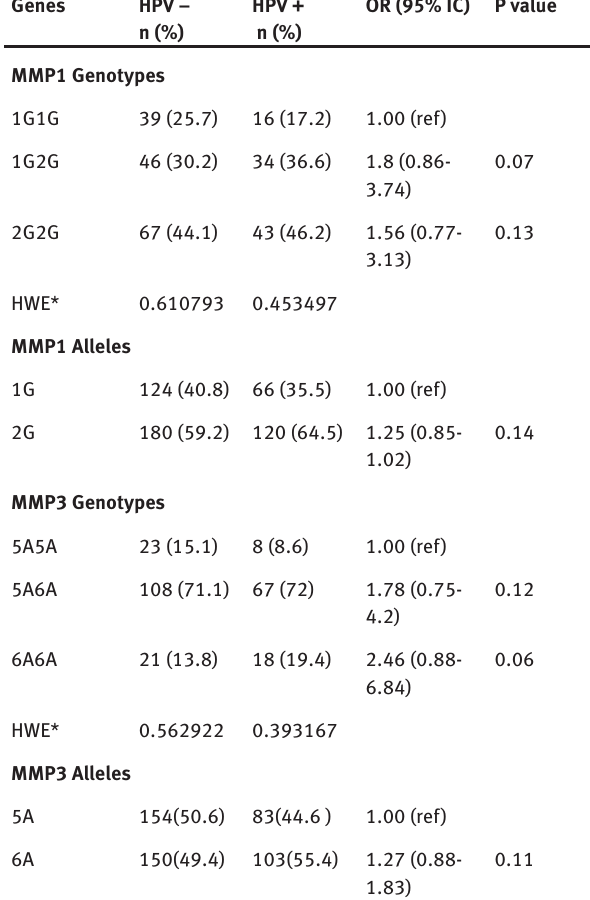
Table 3: Frequency of allelic and genotypic distribution of the polymorphism of the MMP1 and MMP3 genes in women infected or not infected with